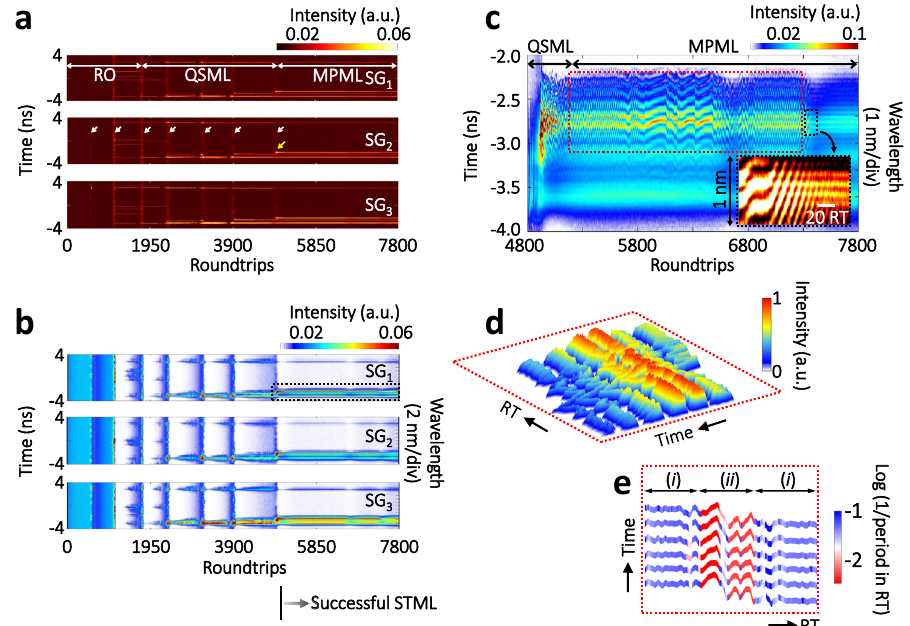
Fig. 2 MUST birth of the multipulse STML started from successive shockwaves. a Temporal evolutions of the multipulse STML birth. Here, three speckle grains, i.e., SG 1 – 3 as indicated in Fig. 1c, are simultaneously observed. Before successful STML, seven shockwaves have been successively generated (white arrows). After each shockwave, multiple sharp pulses in different patterns are survived or short-lived. b Corresponding spectral evolutions. To facilitate the understanding of the wavelength-to-time mapping, the results of the time-stretch measurements in the birth stage are plotted with double Y axis, i.e., time (left) and wavelength (right), which has also been adopted in the prior work 23 . c Close-up of the spectral evolution in SG 1 , indicated by the black dotted rectangle in b . Inset exhibits the transient interference fringes resulted from the strong binding effect. The complicated nonlinear interactions between coexisting STML pulses give rise to the complex spectral evolutions. d , e 3D plot and interference frequency evolution of the area indicated by the red dotted rectangle in c . More details have been provided in Supplementary Note